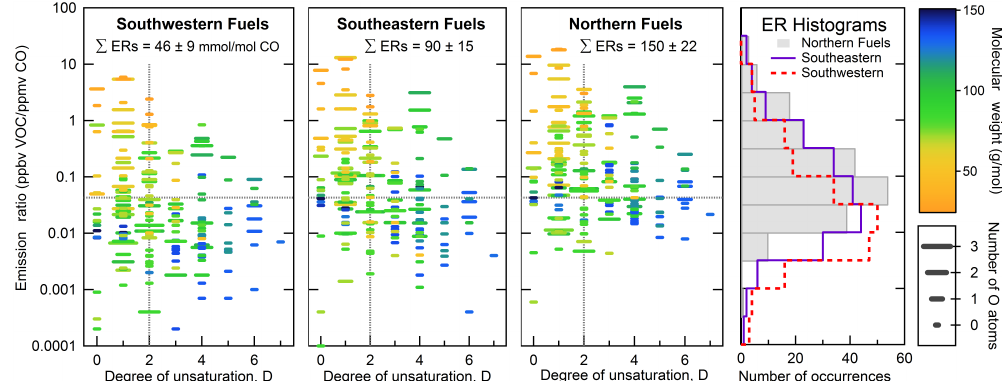
Figure 4. Discrete molar emission ratios for all VOCs reported in Table 2 as a function of the degree of unsaturation, D , for each fuel region. Emission ratios are colored by the corresponding molecular weight and the marker width represents the corresponding number of oxygen (O) atoms. The dashed lines represent the median values for all VOCs from all fuel regions (ER = 0.0427mmol per mol CO and D = 2). The histogram on the right summarizes the distribution of molar emission ratios for each fuel